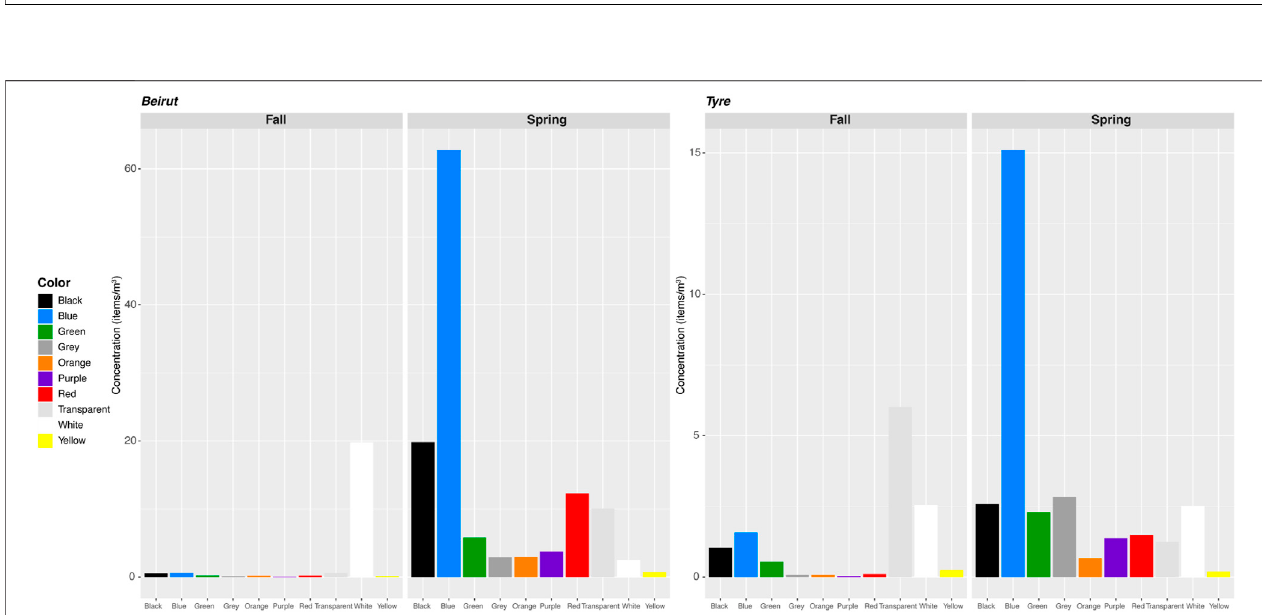
FIGURE 9 | Microplastics concentration (item/m 3 ) according to colors for the marine areas of Beirut and Tyre during fall and spring seasons.